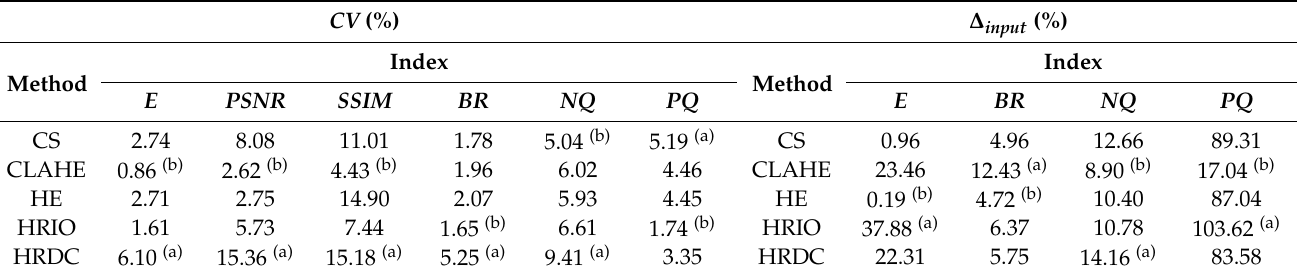
Table 3. Coefficient of variations ( CV ) and index change concerning input image quality ( ∆ input ) . CV (%) ∆ input (%)